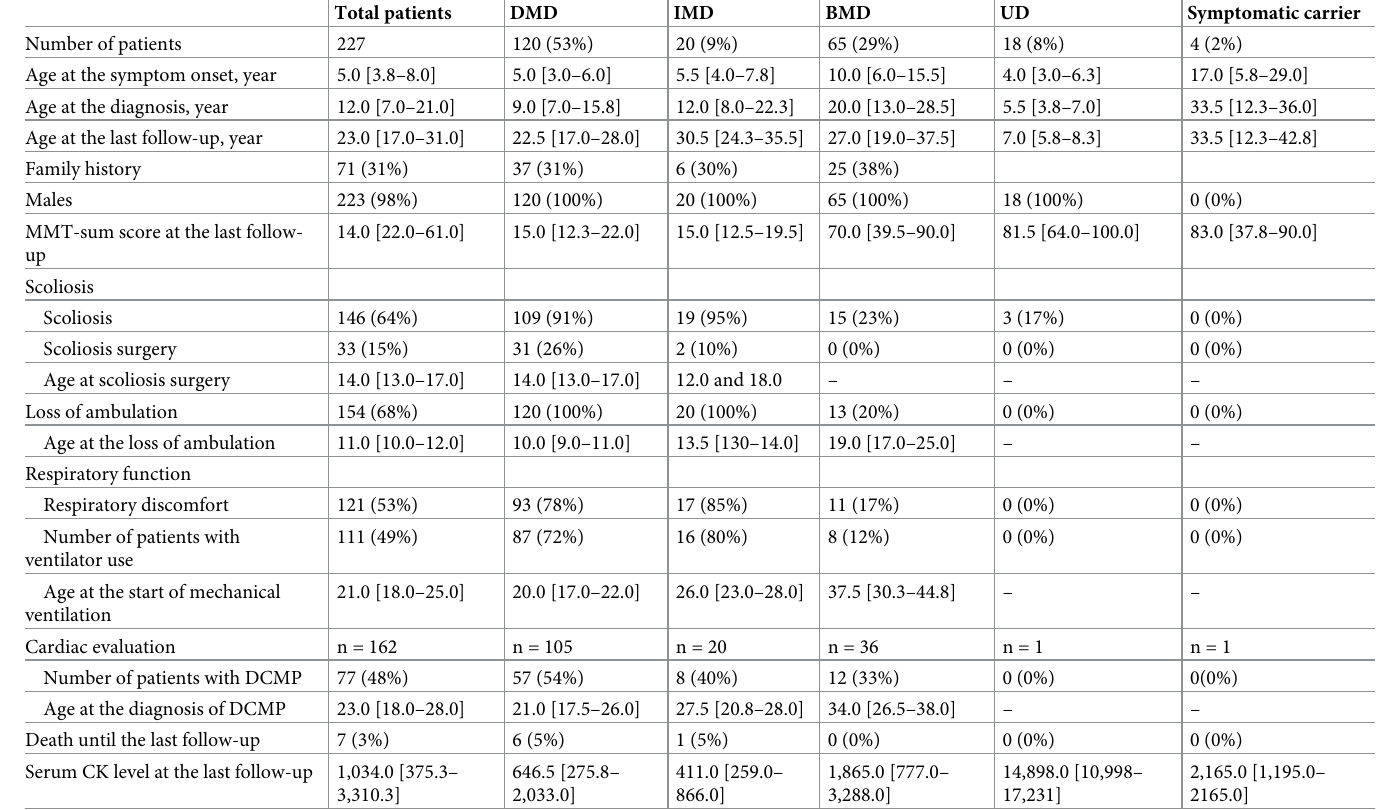
Table 1. Clinical characteristics of 227 Korean patients with